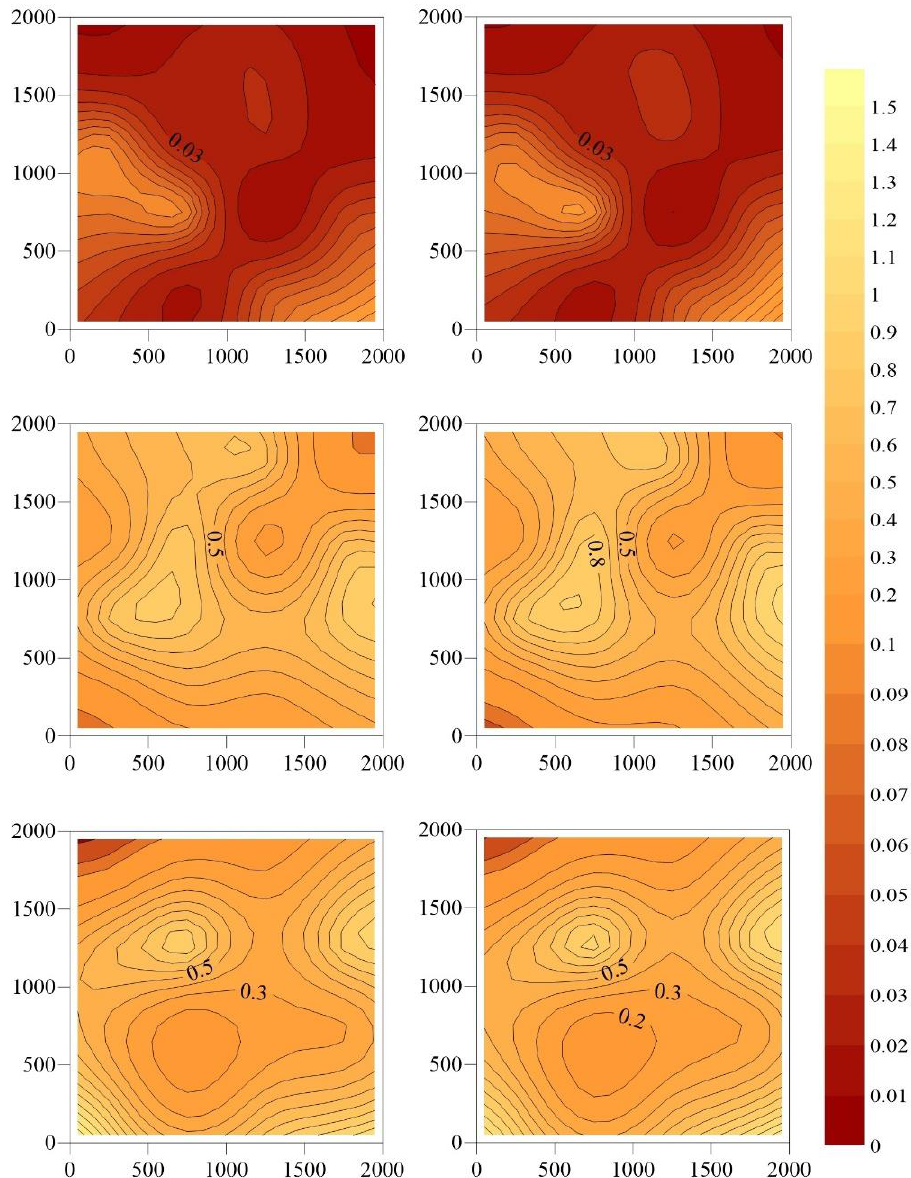
( ) | | 𝜀 ∈ 0.0075; 0.01 (on the right), per- 𝑖